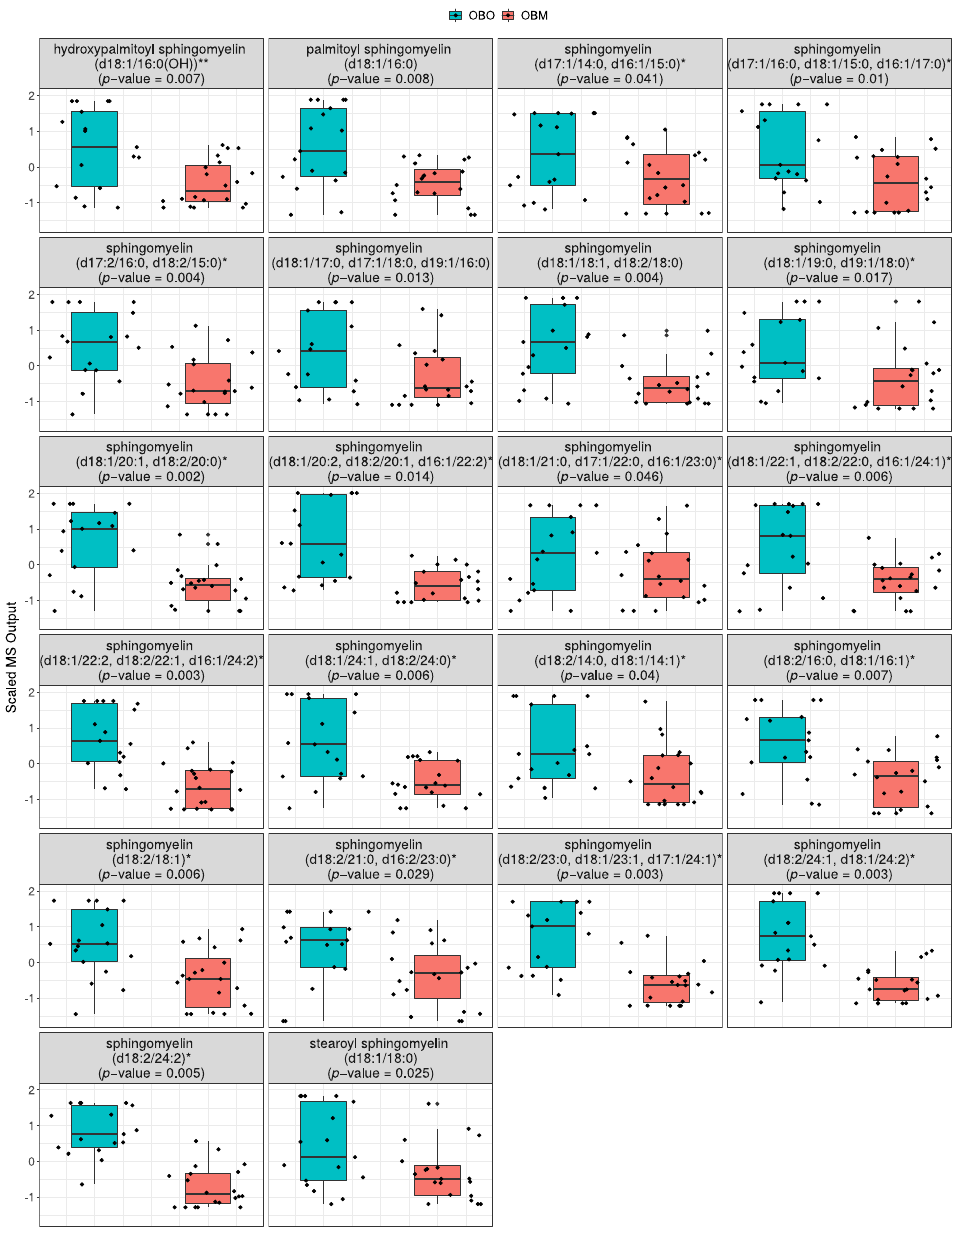
Figure 2. Distribution of statistically significant sphingomyelins in OBO ( left groups) and OBM ( right groups). The box plots are supplemented with violin plots to show distribution of samples across different MS values of the sphingomyelins.